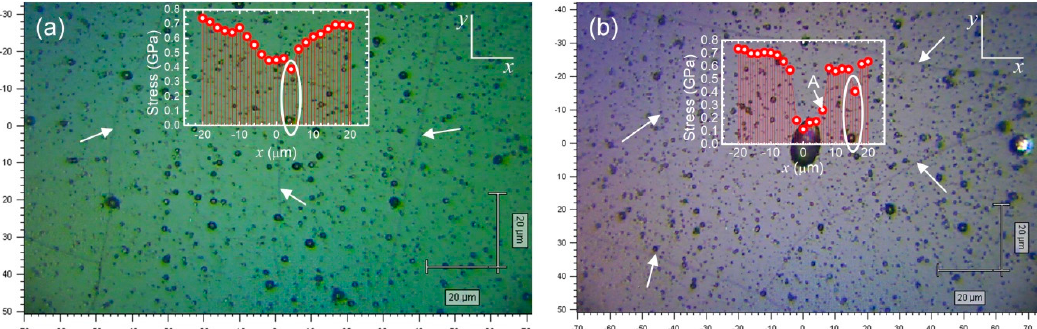
Figure 5. Distribution of residual stress in the micro-area with a crack ( a ) and the micro-area with Cr 2 O 3 macroparticles ( b ). The white arrows indicate the position of the cracks.